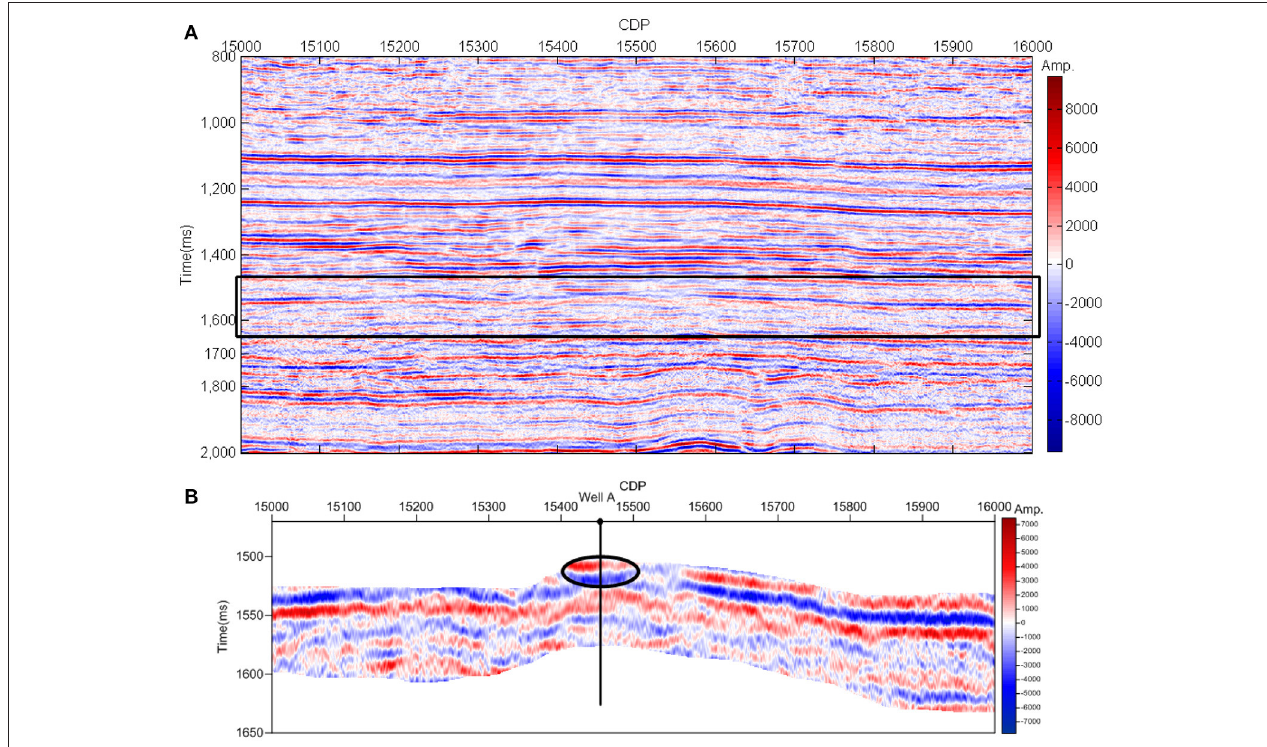
FIGURE 6 | the orignal seismic section and the study area setting. (A) The original two-dimensional broad-band migrated stacked seismic data with the time ranges from 800 to 1,200ms. The black rectangular area is the study section. (B) The studied part of the seismic section between two horizon lines.